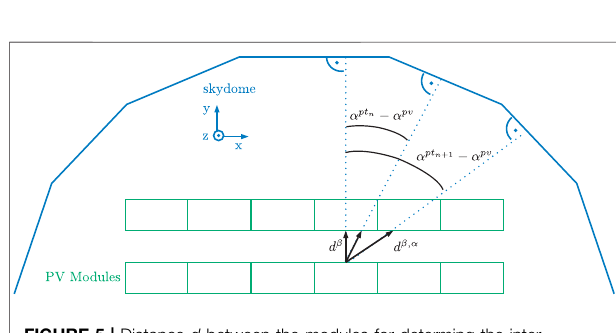
FIGURE 5 | Distance d between the modules for determing the inter- modular shading depending on the relative azimuth orientation α pt − α pv